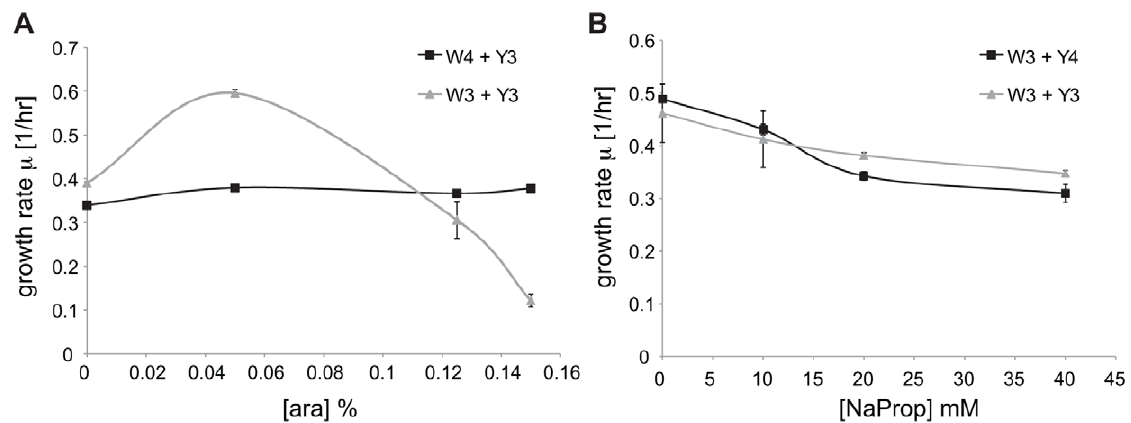
Figure 4. Negative control experiments. ( A ) Addition of arabinose has no effect on the growth rate of the negative tryptophan control strain (W4) and the positive tyrosine strain (Y3). ( B ) The growth rate of both cultures is decreased with the addition of increasing amounts of propionate, but the growth rate decreases less with the addition of the cross-feeding genes. For both ( A ) and ( B ) the negative control strain is either W4 or Y4. See Table S1 for the complete strain genotypes.